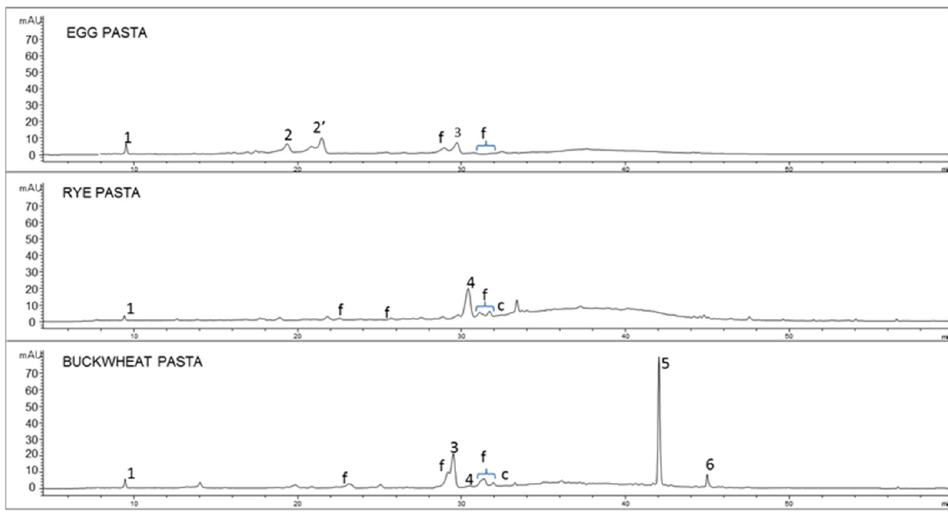
Figure 1. Chromatographic profile (Relative abundance as y axis vs Retention time as x axis) ac- quired by HPLC-DAD (350 nm) of the hydroalcholic extracts of cooked buckwheat pasta, rye pasta, egg pasta. Identified compounds: 1 = indoleacetic acid derivative, 2,2 ′ = apigenin diglico- sides, 3 = rutin, 4 = ferulic acid, 5 = quercetin, 6 = kaempferol, f = flavonoids. Table 1. Caffeic derivatives (caffeic der), flavonoids and indoleacetic acid derivative (IAA der) content in cooked pasta samples. Data are the mean of three determinations (standard deviation < 5%). The percentage of single classes of identified compounds is shown in brackets.